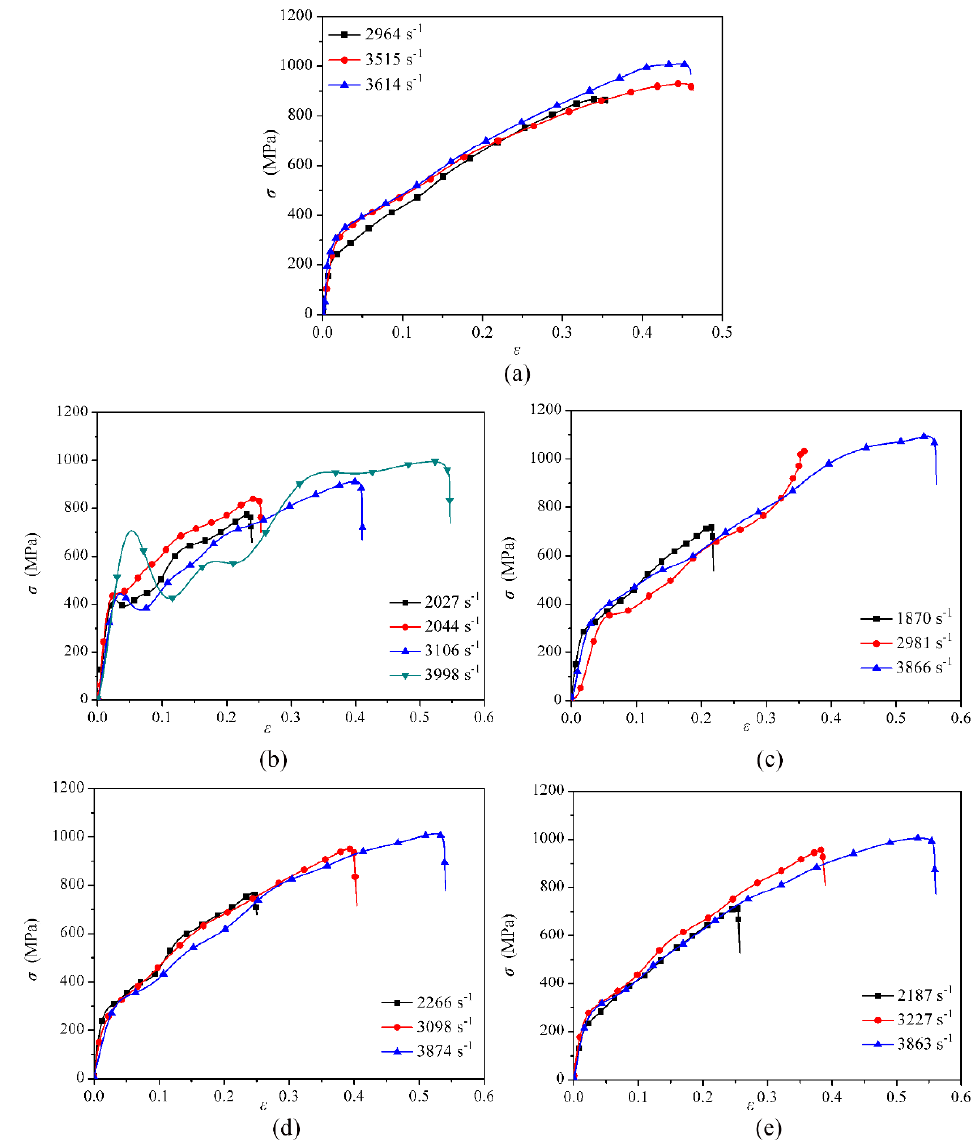
Figure 11. Dynamic compression states of FeNiCoCr HEAs annealed at different temperatures: ( a )